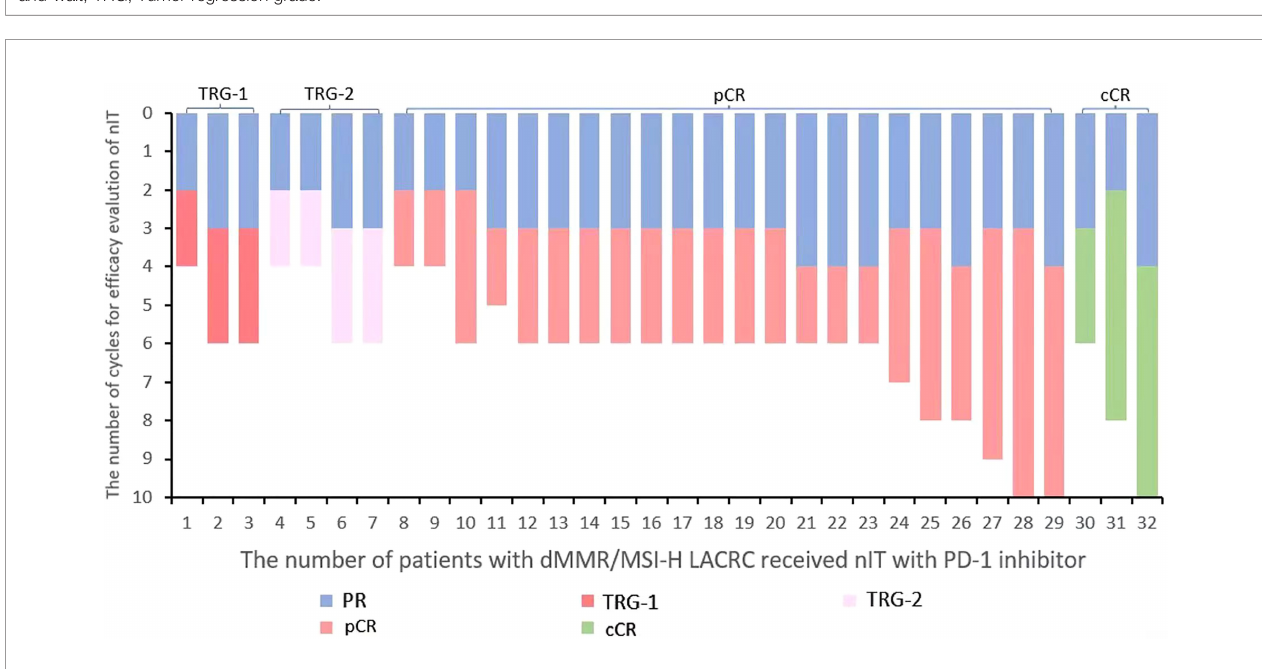
FIGURE 1 | Study pro fi le of nIT in patients with LACRC. LACRC, Locally advanced colorectal cancer; LARC, Locally advanced rectal cancer; LACC, Locally advanced colon cancer; dMMR, Mismatch repair-de fi cient; MSI-H, Microsatellite instability-high; MSS, Microsatellite stability; nIT, Neoadjuvant immunotherapy; nCRT, Neoadjuvant chemoradiotherapy; nCT, Neoadjuvant chemotherapy; cCR, Clinical complete response; pCR, Pathological complete response; W&W, Watch- and-wait; TRG, Tumor regression grade.